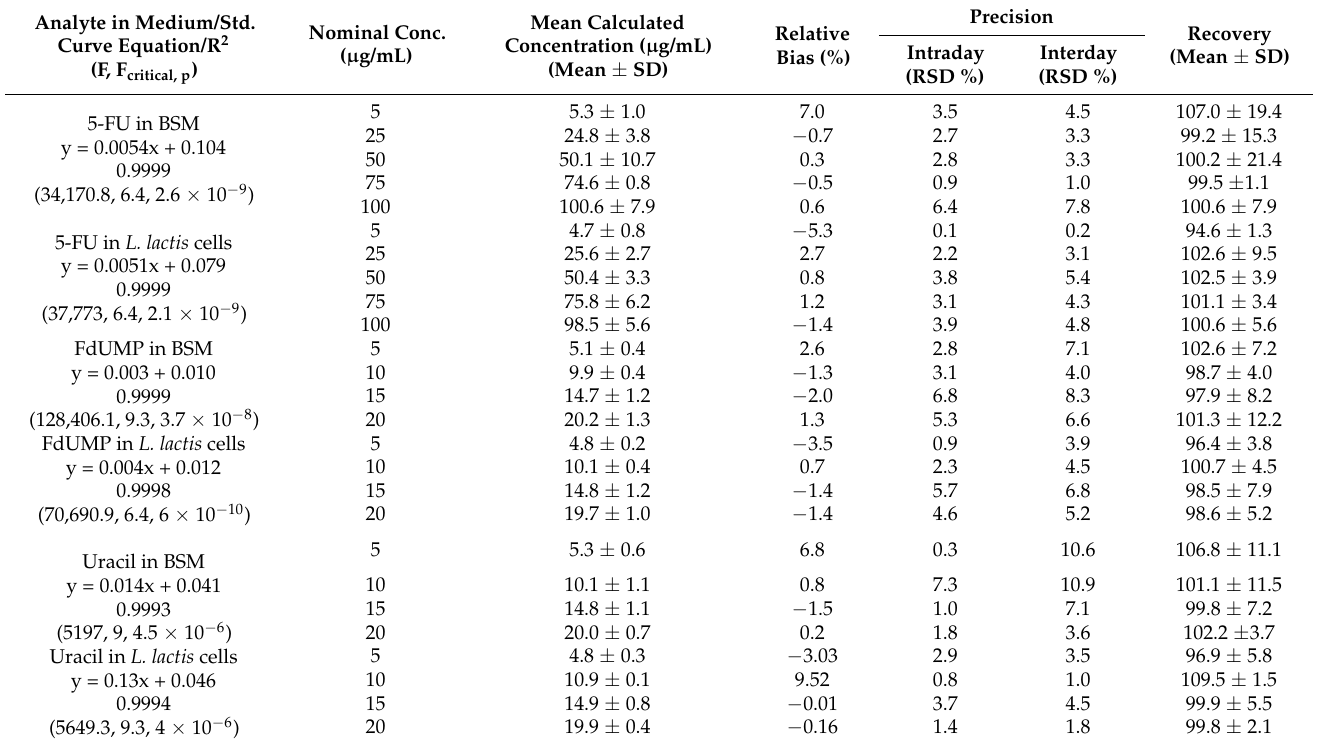
Table 1. Validation parameters for the determination of 5-FU, 5-FUMP, and uracil. Results for the Mean Calculated Concentrations and Recoveries are expressed as mean ± SD ( n = 3). In calculations for Intraday Precision n = 3, and for Interday Precision n = 6 over three days.